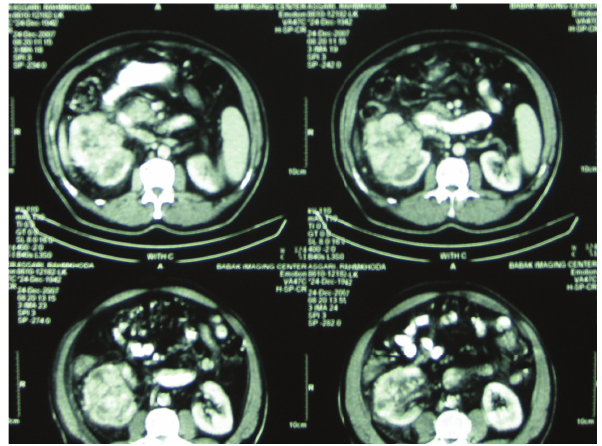
Figure 2: Contrast enhanced abdominal CT scan, revealing the left renal